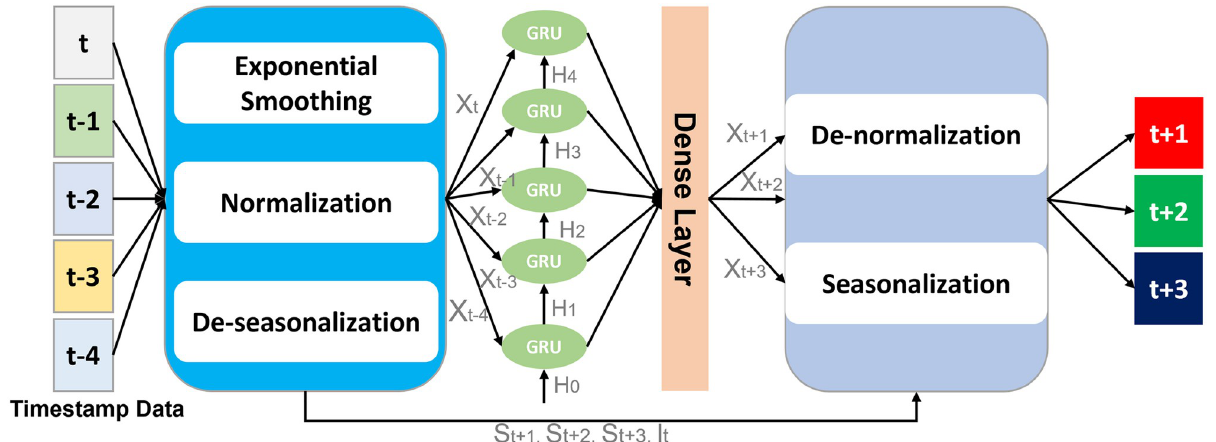
Fig 3. Architectural details of bi-directional LSTM and ES